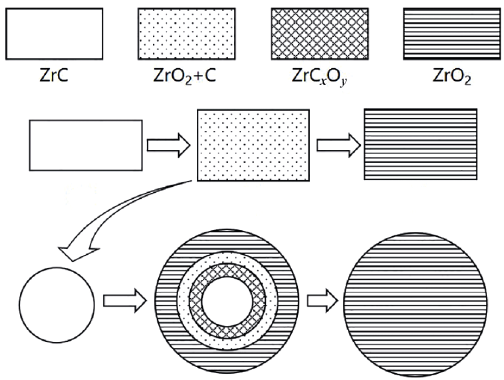
Fig. 10 Mechanistic model for the oxidation of ZrC to ZrO 2 . Reproduced with permission from Ref. [158], © Elsevier B.V.